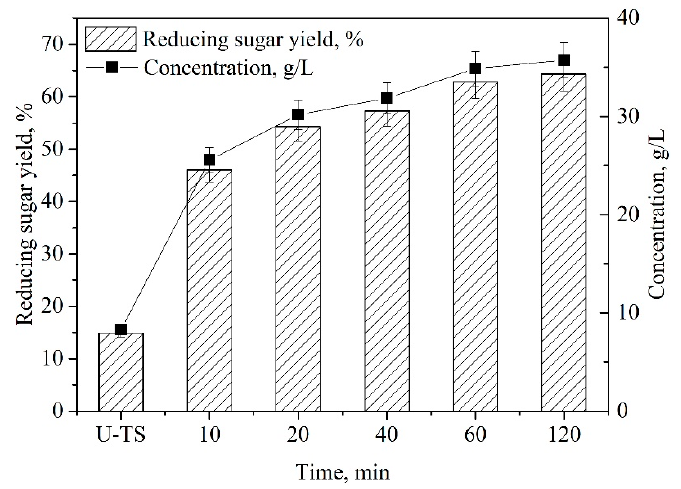
Figure 4. Effects of TS pretreatment duration on the enzymatic saccharification of TS. [Pretreatment condition: NaOH (7 wt%)–ChCl:UA-TA (8 wt%), 75 °C, 10 − 120 min; Enzymatic hydrolysis condition: cellulase (10.0 FPU/g TS) and xylanase (30.0 CBU/g TS), 50 °C, pH 4.8]. [U-TS represents untreated TS].